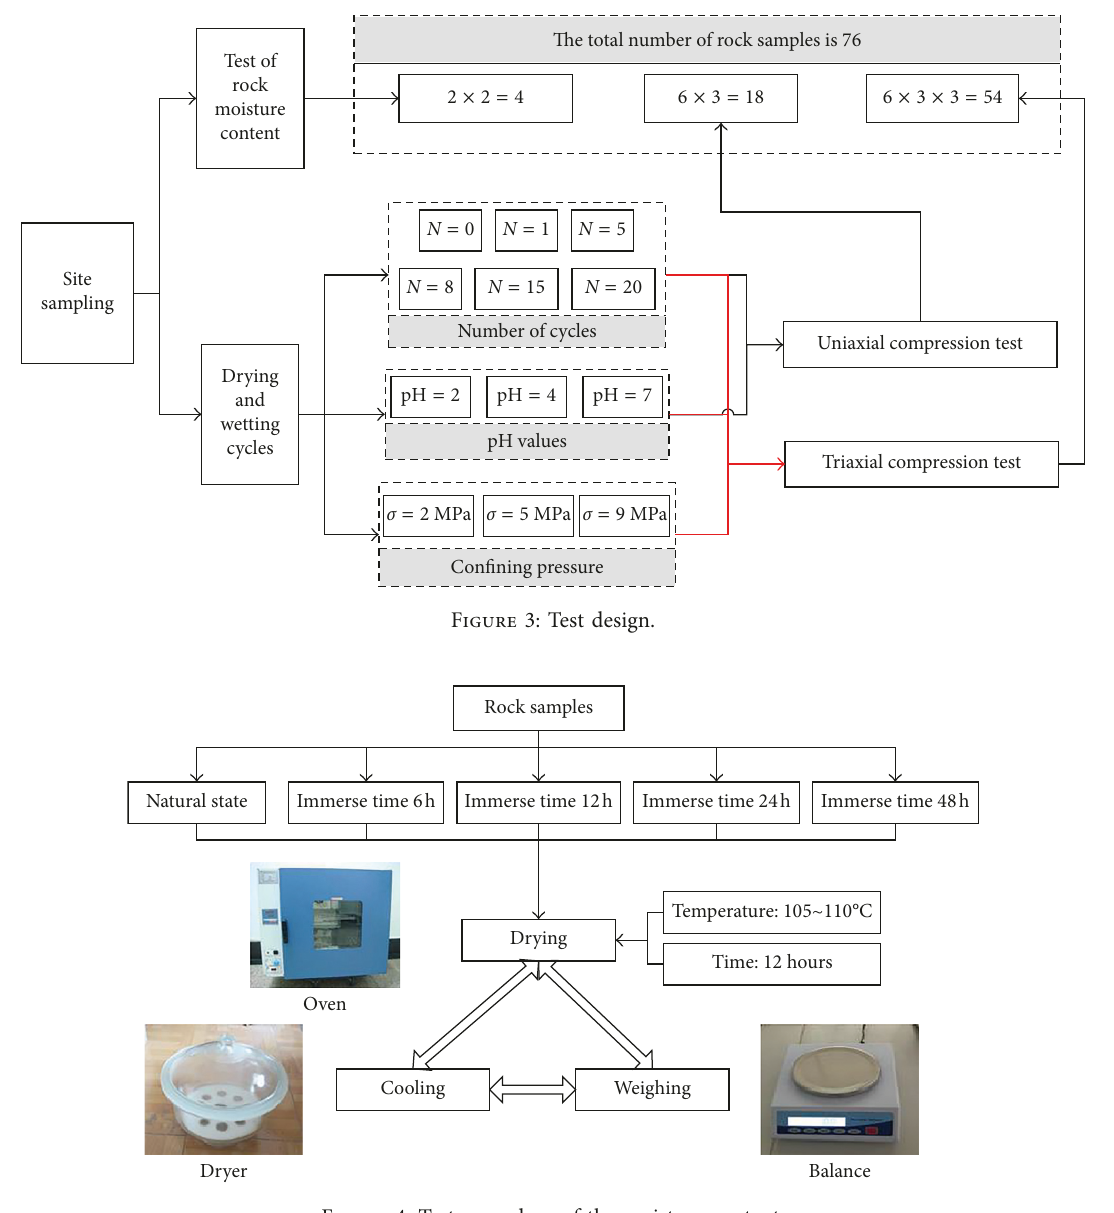
Figure 4: Test procedure of the moisture